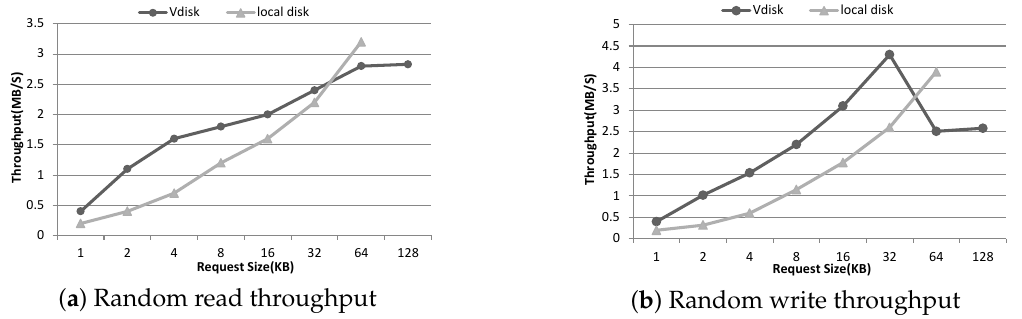
Figure 9. The performance results on random read throughput ( a ) and write throughput ( b ) of the service and storage layer.